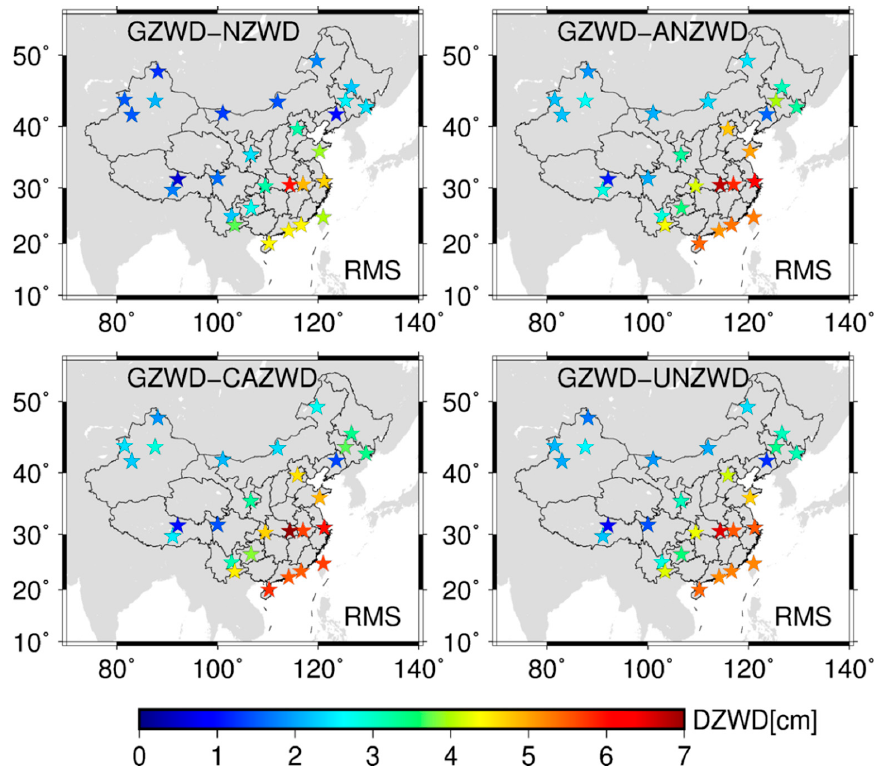
Figure 6. Statistical analysis of deviation between GZWD and model-derived ZWD. See the main text for an explanation of abbreviations.